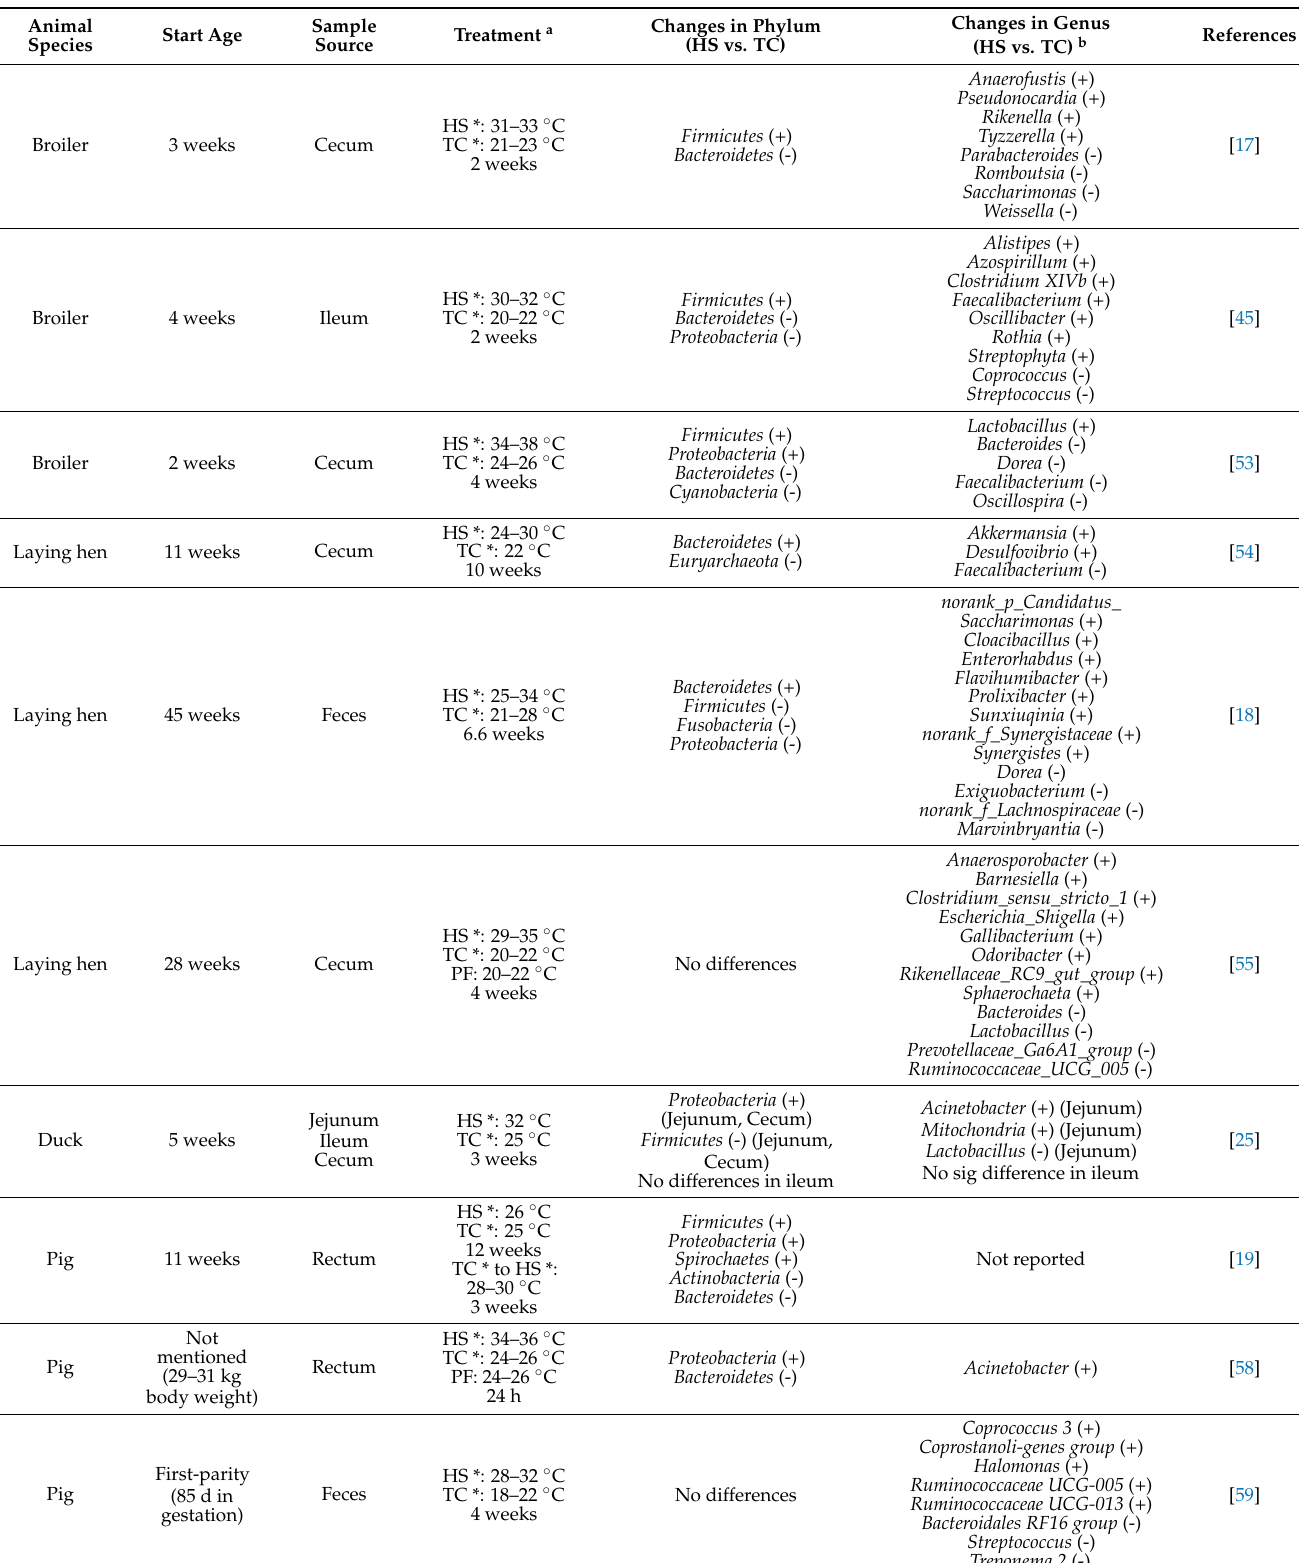
Table 1. Summary of published alternations in the gut microbiota induced by heat